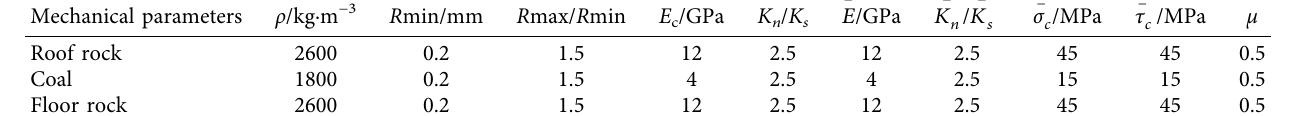
Table 1: Micromechanical parameters of coal and rock [2, 3, 22, 23].